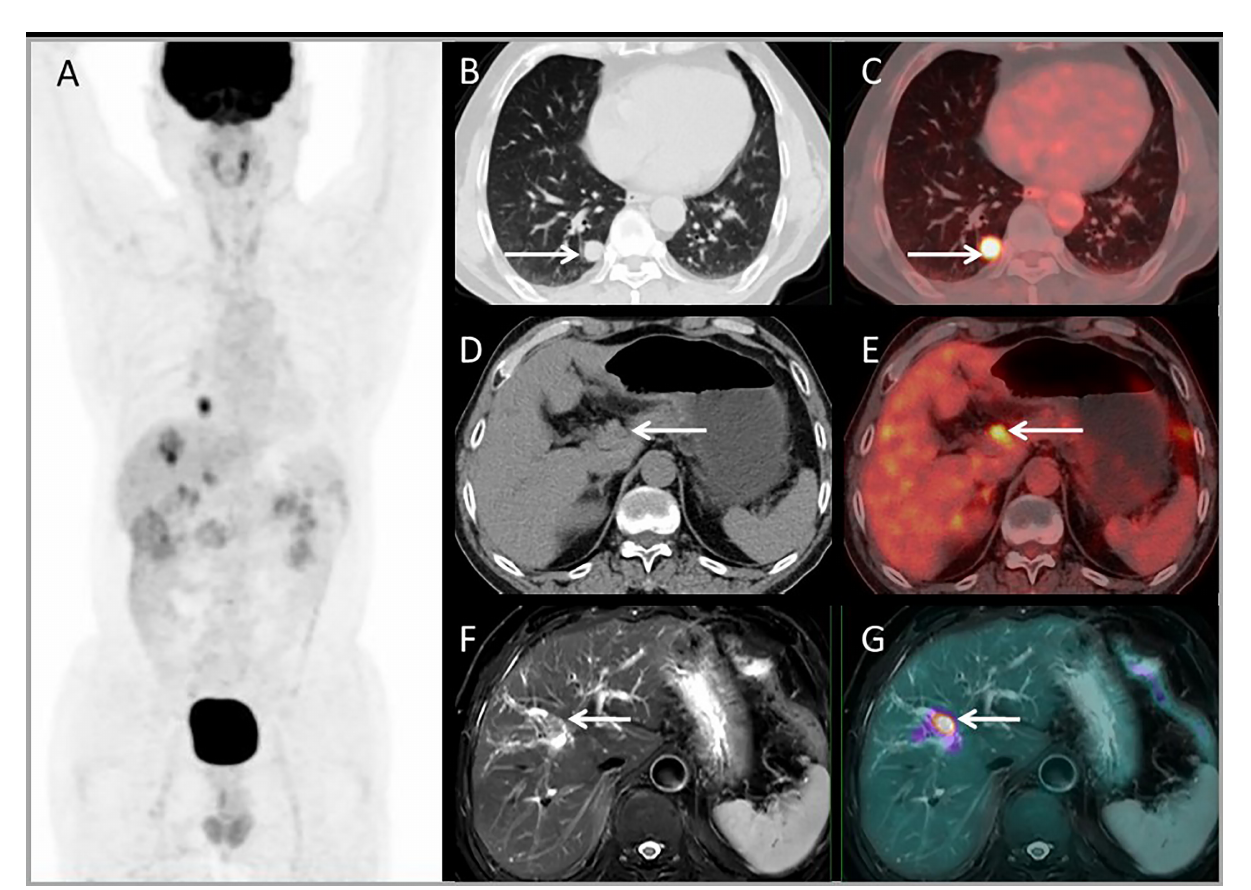
FIGURE 5 | Images of a 64-year-old male with colonic liver metastasis. The MIP (A) of PET/CT showed a single lesion on the liver and EHD lesions. CT and PET/CT fusion images showed single lung metastasis (B, C) and hilar lymph node metastasis (D, E) . T2WI and PET/MR fusion images showed single liver lesion with intrahepatic bile duct in fi ltration (F, G) .